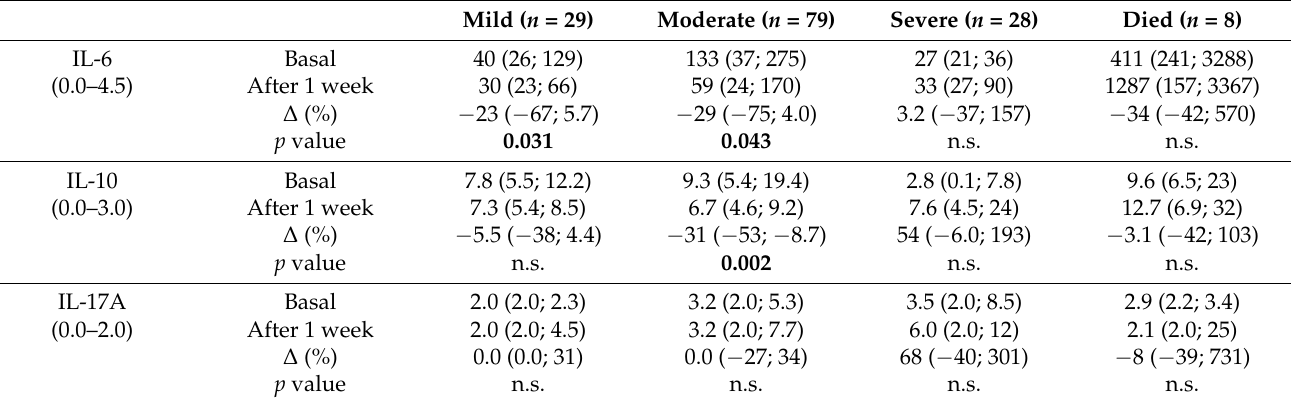
Table 2. Comparison of serum ILs (pg/mL) in 144 COVID-19 patients with different severity at hospital admission (basal) and after 1 week. Median (interquartile range). For each parameter, we report the reference